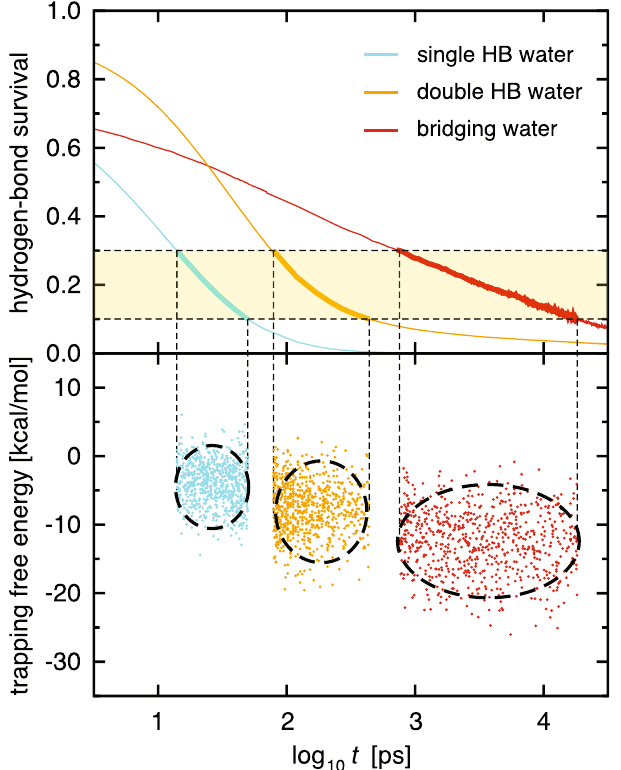
Figure 5. Construction of the thermodynamic–dynamic relationship diagram. Upper panel: Hydrogen-bond time-correlation functions for single HB water (cyan), double HB water (orange), and bridging water (red) taken from Fig. 4, focusing on the time regime where the functions decay from 0.3 to 0.1 (light yellow). Lower panel: Scatter plots of the hydrogen-bond survival times ( τ i ) and trapping free energies ( G water molecules. Centers of ellipsoids are determined by the averages, and the width and hight are determined by 3.6 σ (where σ is the standard deviation) along each